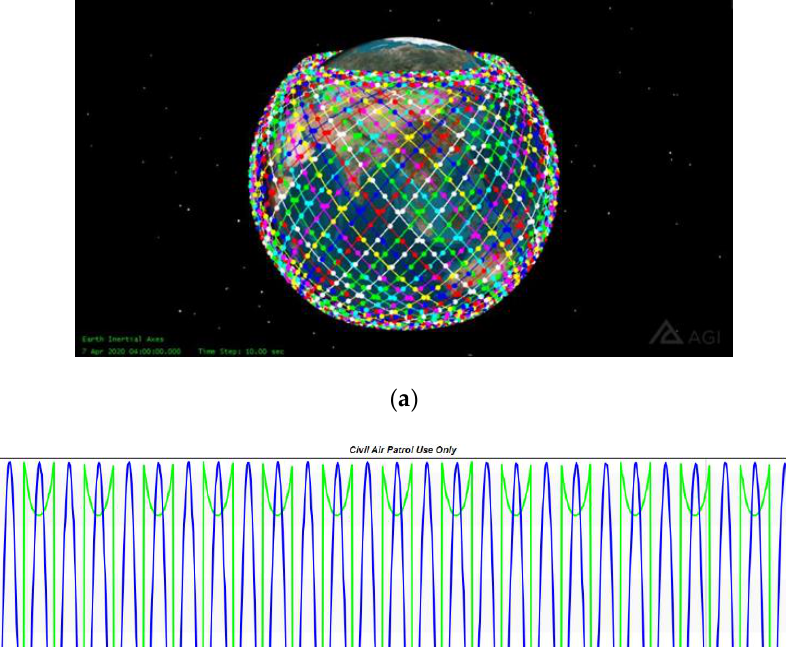
Table 1. The orbit parameters of satellites.